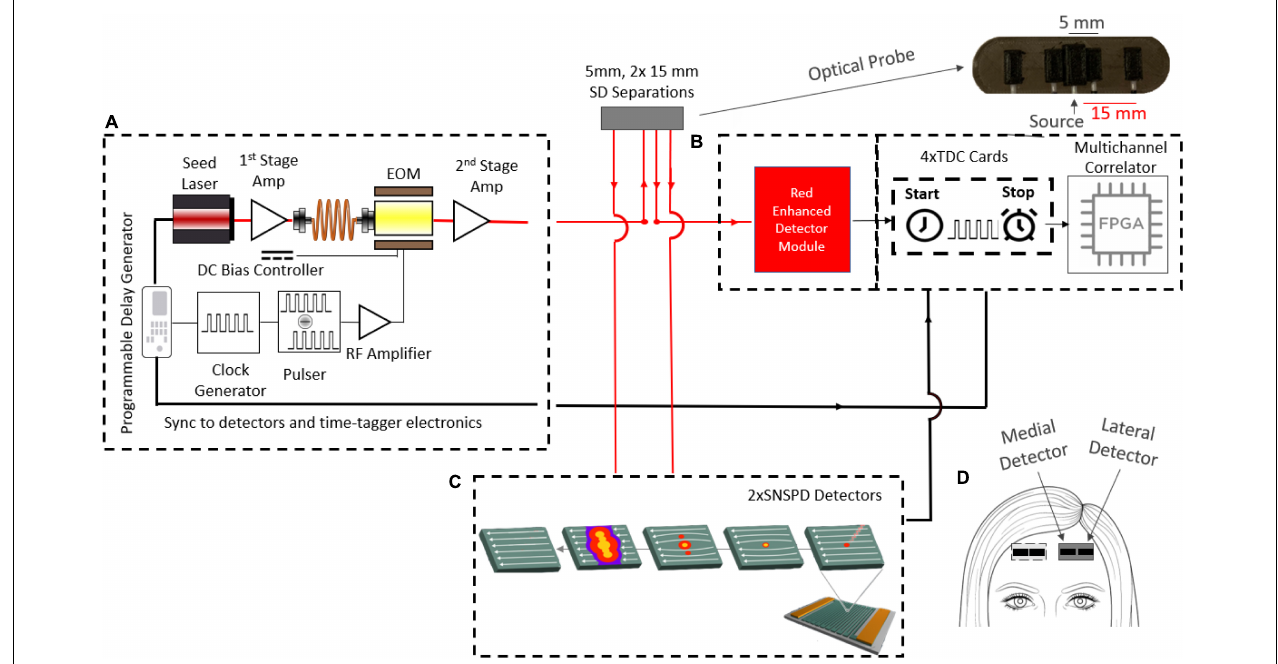
FIGURE 1 | Schematic diagram of the experimental setup. (A) Custom 1,064 nm two-stage fiber amplified pulsed laser. The pulsed system can emit 100 mW average power with at a repetition rate of 1–100 MHz and an adjustable pulse FWHM from 150 to 600 ps. The first stage amplifier is fed by the pulsed seed laser and its output is spliced to the EOM input, while the EOM output feeds the second stage amplifier. The second stage output is spliced to a 62.5 µ m multimode 90:10 fiber splitter. The 90% fiber is finally spliced to the delivery probe and the 10% fiber is used for measuring the instrument response function (IRF). The optical probe consists of a source fiber, two detector fibers at 5 mm (only one was used) and another two detector fibers at 15 mm separation. (B) The TD detection module consists of an MPD-RE detector for short separation (5 mm) measurements and (C) 2 SNSPD detectors for the long separation (15 mm) measurements. A custom time-tagger with four TDC cards and an FPGA board were used to record the micro times (ToF) and the macro times (absolute times of arrival). (D) The DCS optical probe, consists of medial and lateral detectors was attached to either side of the forehead. Measurements during functional tasks were repeated on both sides of the forehead (left and right hemispheres) on each subject.